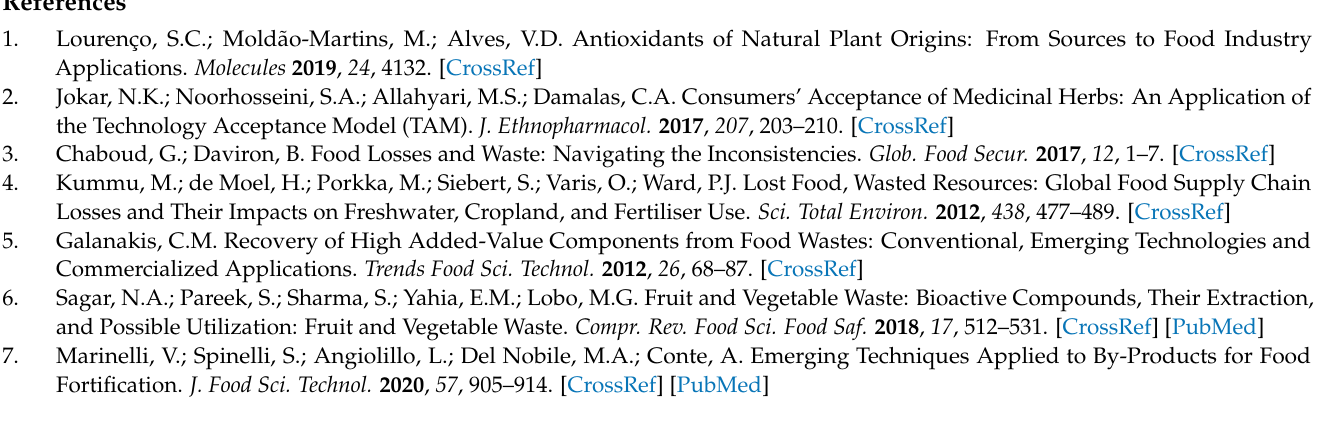
ionization mode); Figure S5: Dittany’s total ion chromatogram (negative ionization mode); Figure S7: Rosehip’s total ion chromatogram (negative ionization mode); Figure S8: Rosehip’s total ion chro- matogram (positive ionization mode; Figure S9: Bitter orange’s total ion chromatogram (negative ionization mode); Figure S10: Bitter orange’s total ion chromatogram (positive ionization mode); Figure S11: Spearmint’s total ion chromatogram (negative ionization mode); Figure S12: Spearmint’s total ion chromatogram (positive ionization mode); Figure S13: Sideritis’s total ion chromatogram (negative ionization mode); Figure S14: Sideritis’s total ion chromatogram (positive ionization mode); Figure S15: Lemon peel’s total ion chromatogram (negative ionization mode); Figure S16: Lemon peel’s total ion chromatogram (positive ionization mode); Figure S17: Lavender’s total ion chro- matogram (negative ionization mode); Figure S18: Lemon peel’s total ion chromatogram (positive ionization